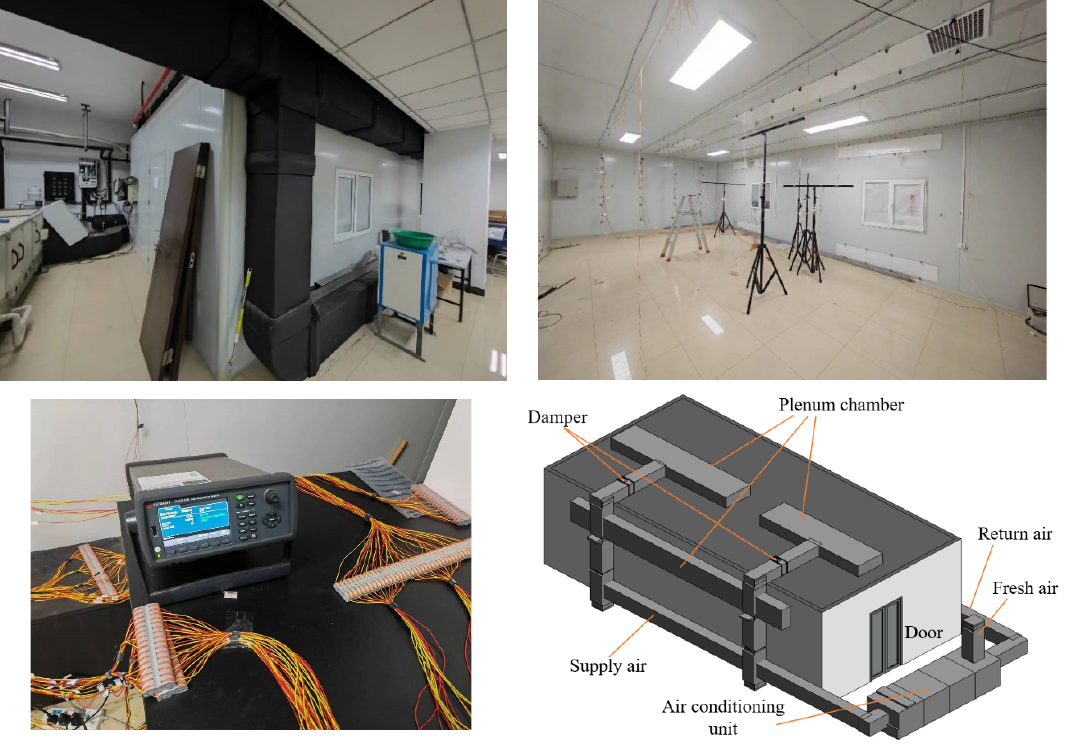
Figure 2. Layout of the experimental setup.